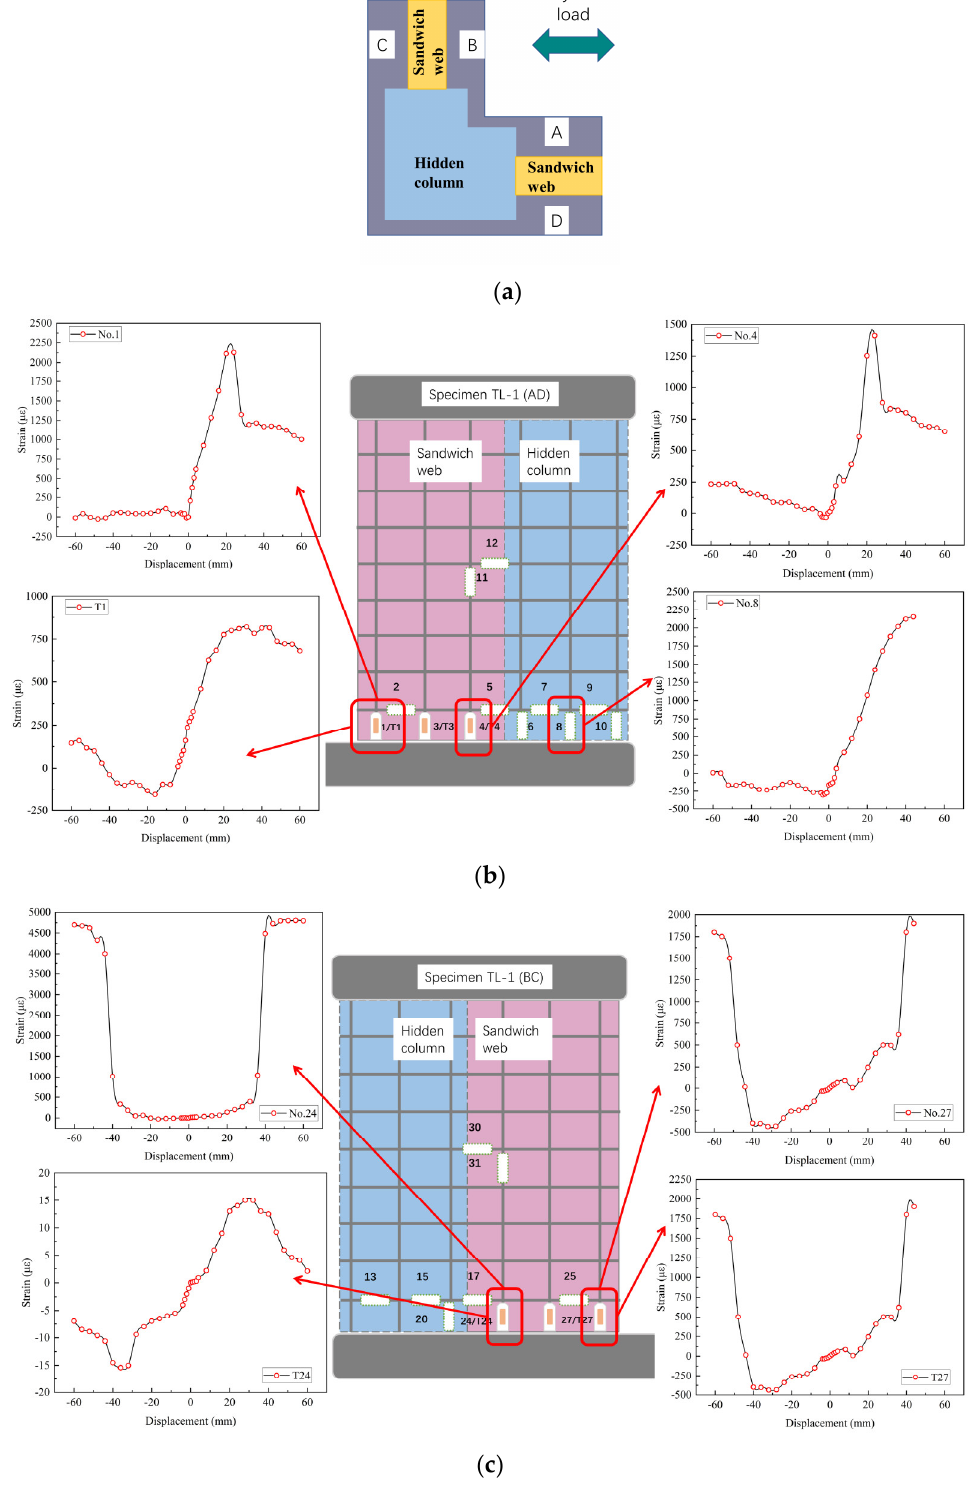
Figure 13. The Strain of longitudinal bar. ( a ) The loading direction. ( b ) The AD web of the joint. ( c ) The BC web of the joint.